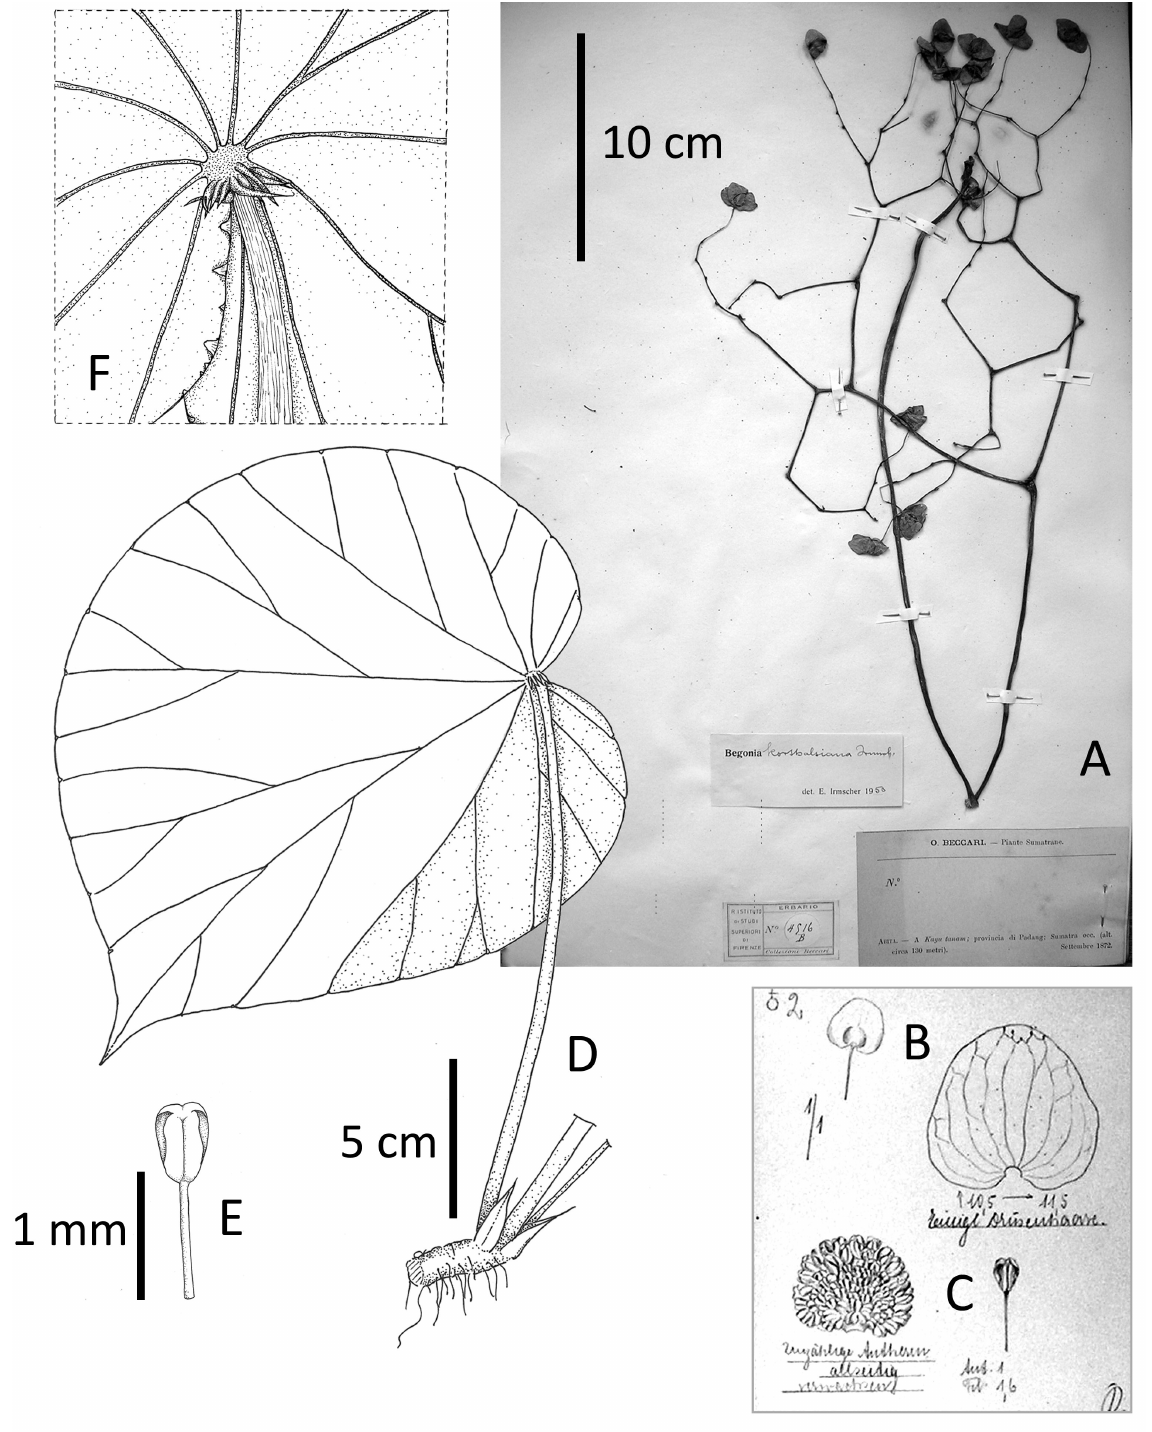
Fig. 10. Begonia korthalsiana Miq. ex M.Hughes sp. nov. A . Infructescence on isotype Beccari PS857 (FI). B . Male flower with pedicel (left), tepal of male flower (right). C . Androecium (left), anther (right). D . Rhizome and leaf. E . Anther. F . Leaf lamina underside at point of petiole attachment showing fleshy bristles. B, C drawn by E. Irmscher from isotype Beccari PS857 (B); D–F drawn by M. Hughes from isotype Beccari PS857